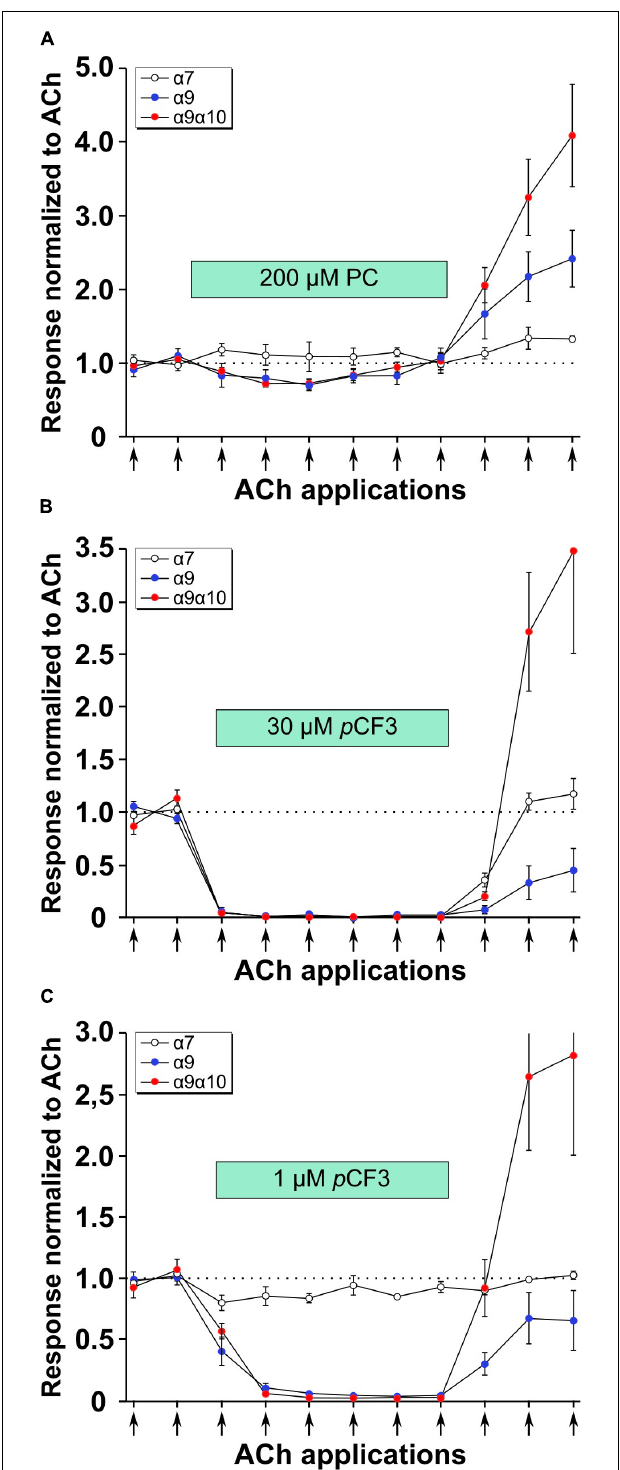
FIGURE 5 | Effects of phosphocholine (PC) and p CF3-diEPP ( p CF3) on the peak current responses evoked by acetylcholine (ACh) on Xenopus laevis oocytes expressing human α 7, α 9 or α 9 α 10 nAChRs. Two-electrode voltage-clamp measurements were performed on Xenopus oocytes